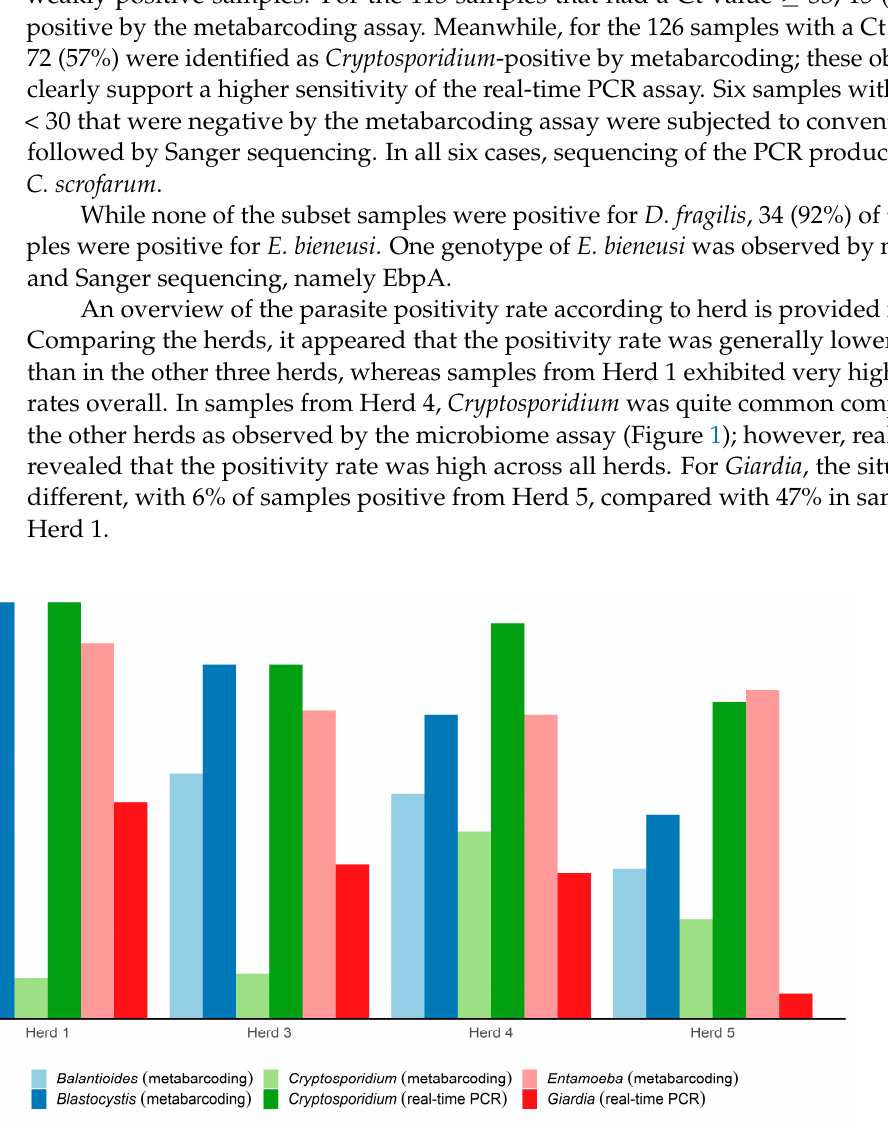
Figure 1. Overview of the proportions of the 259 fecal DNAs from pigs from four different herds in Denmark positive for five parasitic genera, according to herd. For Balantioides , Blastocystis , and Entamoeba , only metabarcoding was used. For Giardia and Cryptosporidium , both metabarcoding and real-time PCR were used ( Giardia failed to be detected by the metabarcoding assay).